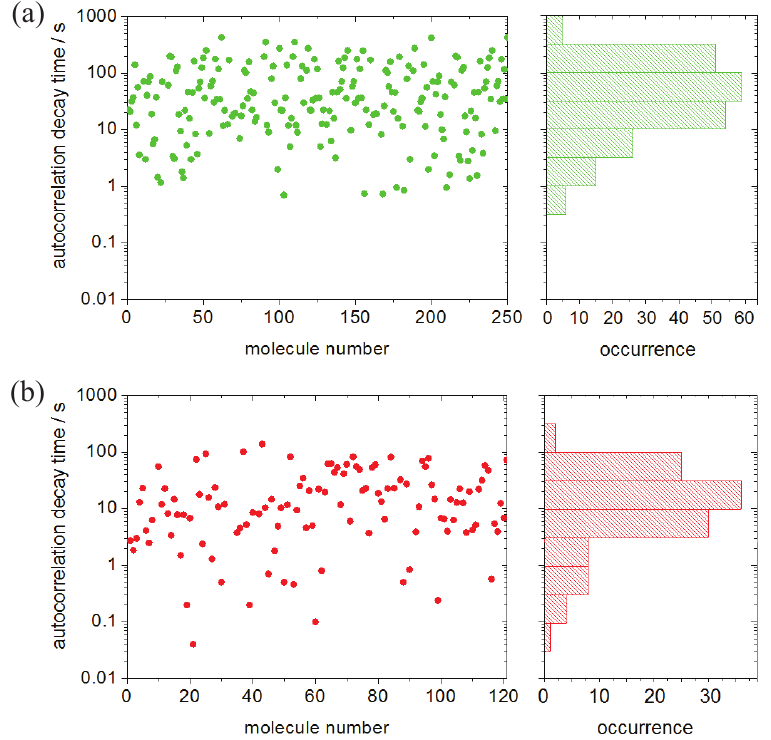
Figure 3. Distribution of the relaxation times obtained for 1 in pvac at (a) 28°C and (b) 33°C.